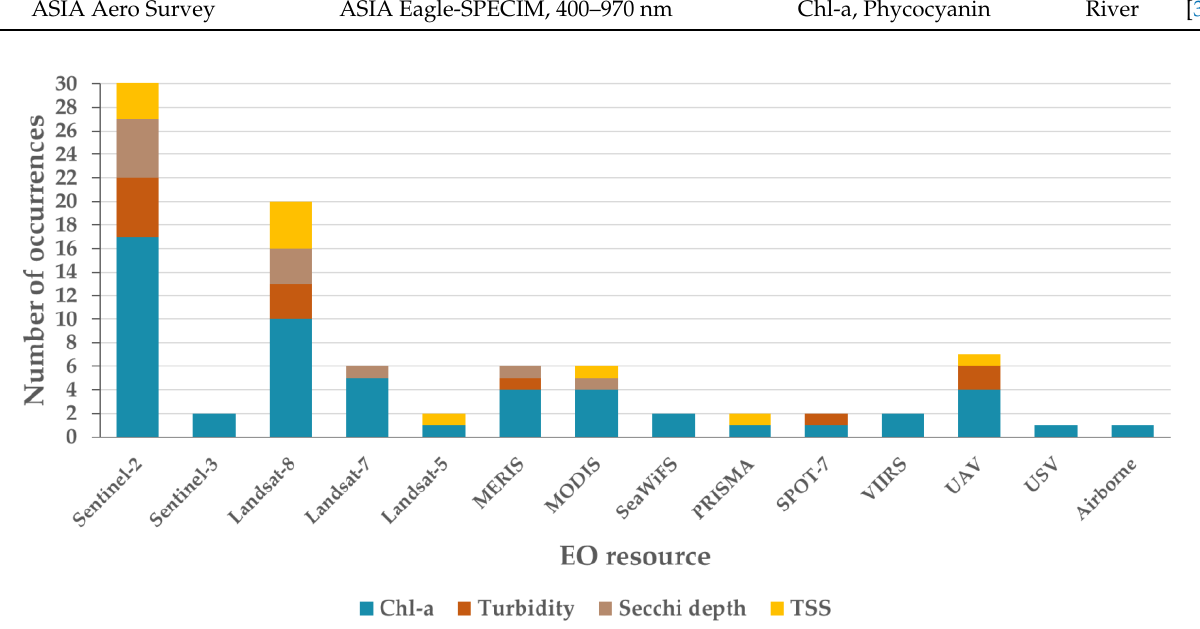
Figure 9. The distribution of the four predominant indicators in terms of EO resources .